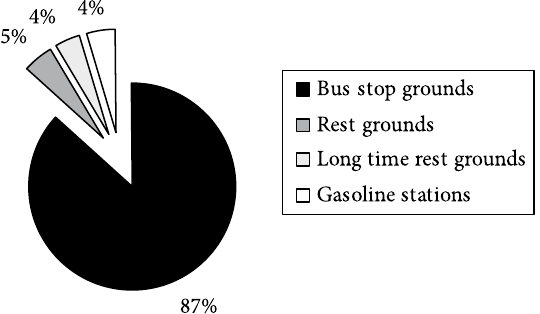
Fig. 4. The repartition of ground considering the main and interurban road networks in